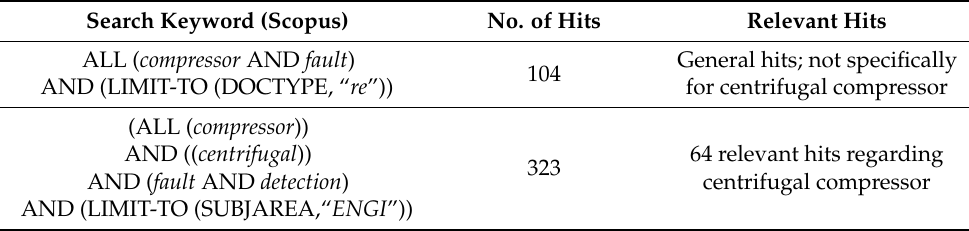
Table 1. Search in Scopus showing the number of relevant